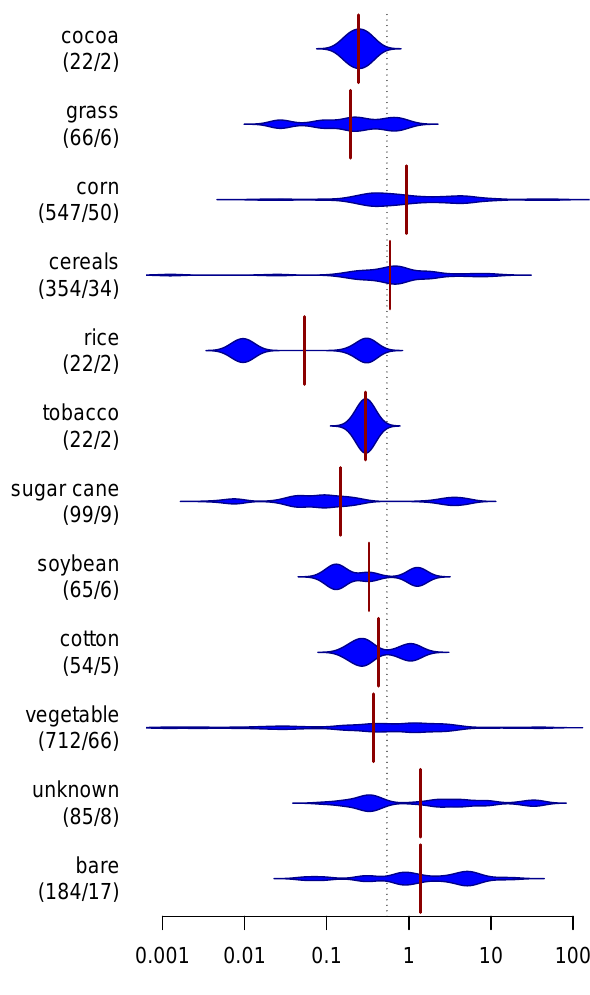
Fig. 10. Distribution of calculated wet emissions factors for dif- ferent crop types in the landcover “agriculture” with the number of calculated emission factors and number of measurements per crop class in